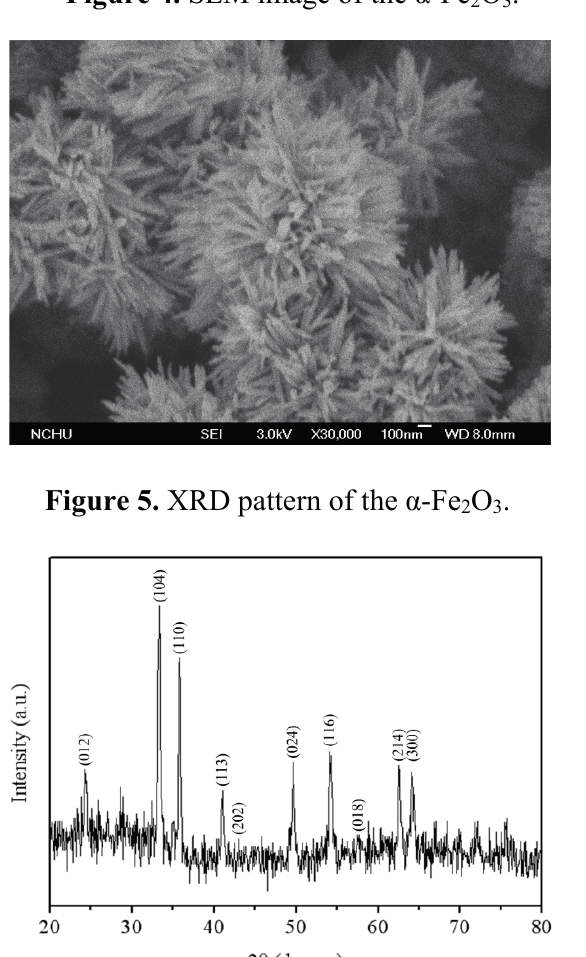
Figure 4. SEM image of the α -Fe